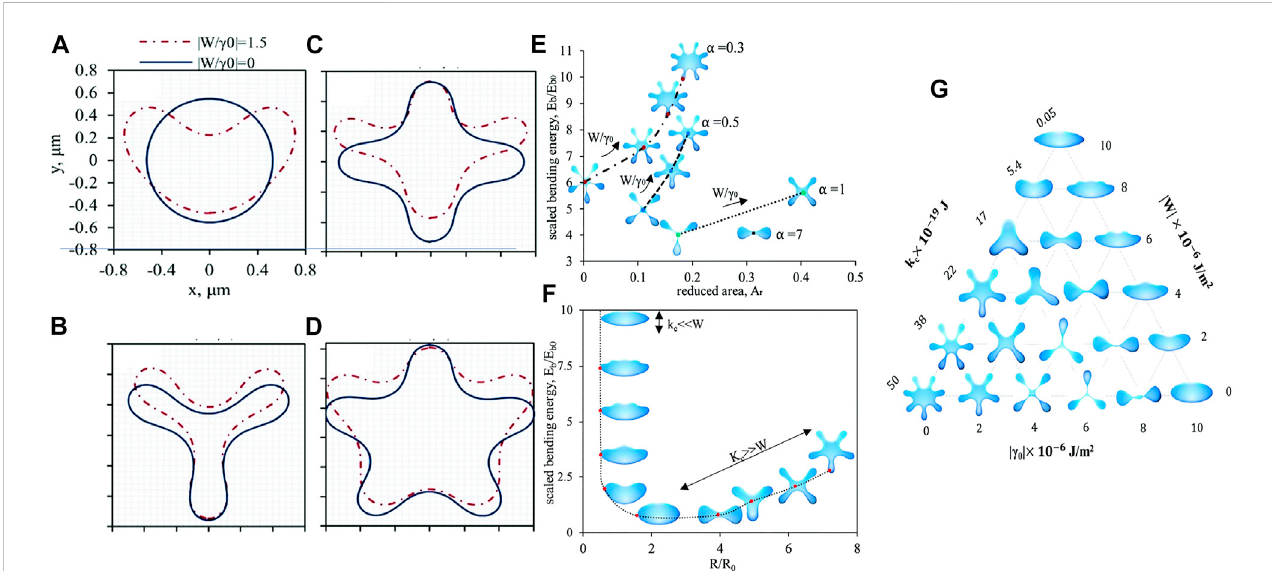
FIGURE 11 Numerical simulation of 1D droplet with an elastic membrane. (A) α =2.5, β =1.25, 2-fold symmetry. (B) α =0.15, β =0.075, 3-fold symmetry. (C) α =0.08, β =0.04, 4-fold symmetry. (D) α =0.05, β =0.025, 5-fold symmetry. (E) The relationship between scaled bending energy and reduced area for α =0.3, 0.5, 0.7 and 1. (F) The relationship between scaled bending energy and the ratio of radius to the spontaneous radius R / R 0 for various k c . (G) The ternary phase diagram for different combinations of bending rigidity k c , surface tension γ 0 and anchoring coef fi cient W . Reproduced from (Rofouie et al., 2017b) with permission from the Royal Society of Chemistry.